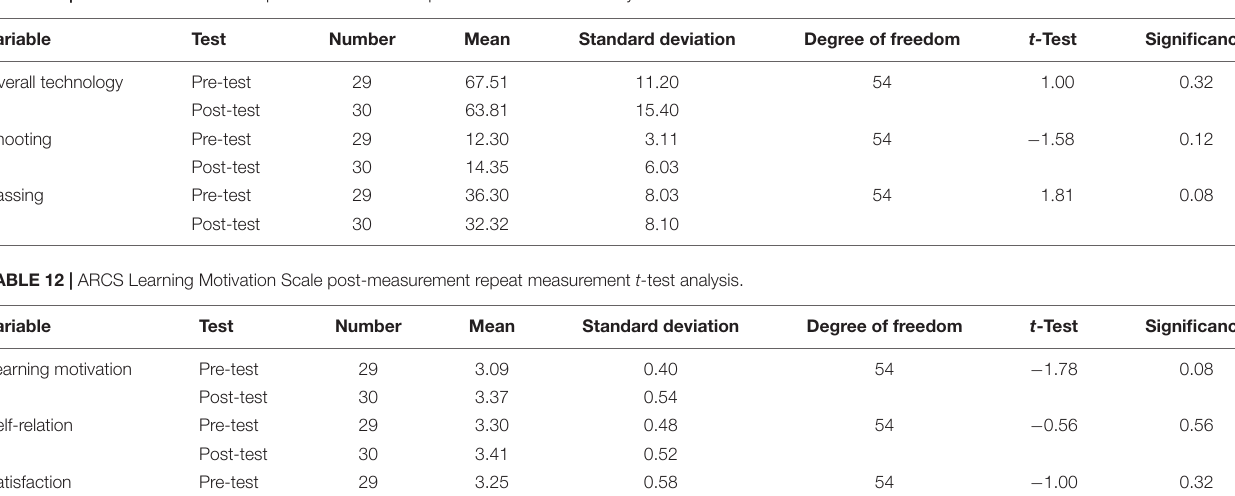
TABLE 11 | Action Skill Performance post-measurement repetition number t -test analysis.